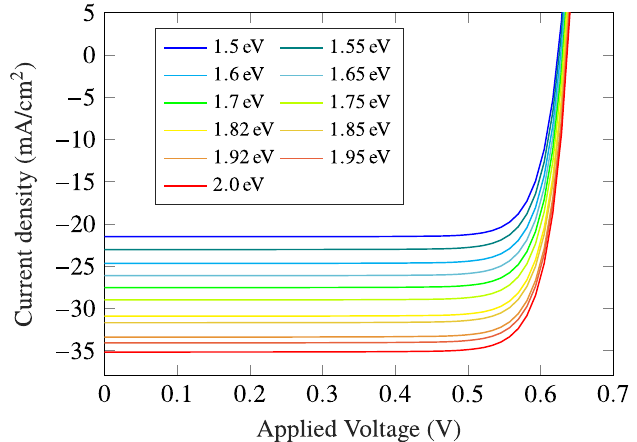
Fig. 5. Simulated J – V characteristics for a fi ltered bottom cell with varying the top cell bandgap. The top cell thickness is fi xed at 350nm. The bottom cells thickness and bandgaps are fi xed at 350 nm and 1.0 eV,